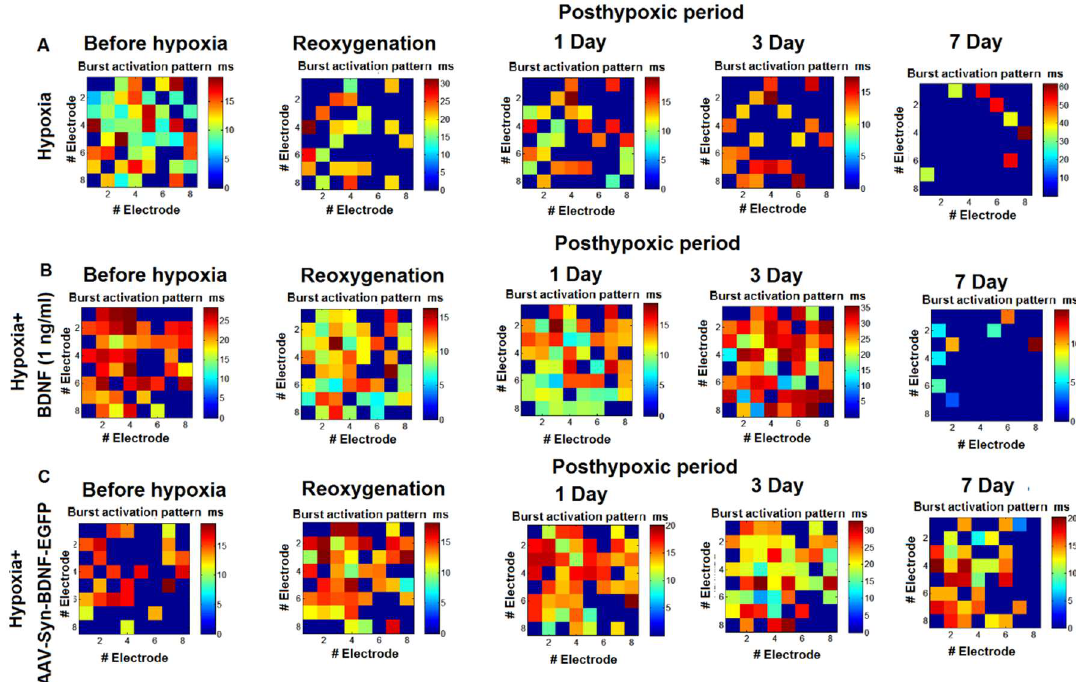
Figure 6. Representative examples of the activation pattern of spontaneous bioelectrical activity in primary hippocampal cultures in the posthypoxic period: A —hypoxia, B —hypoxia+BDNF (1 ng/mL), C —hypoxia + AAV-Syn-BDNF-EGFP. The colour scale corresponds to the time of occurrence of the first spike in the network burst and is presented in squares according to the electrodes of the multielectrode array. The data show that hypoxia induced a decrease in the signal transmission speed in the network and significant changes in the activation pattern of the network burst. BDNF overexpression contributed to maintaining the activation pattern in the posthypoxic period.